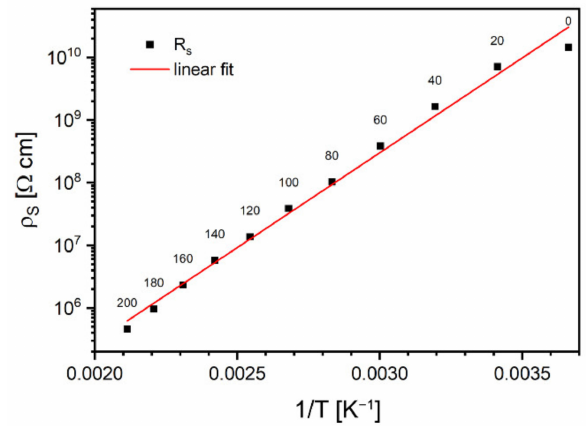
Figure 8. Arrhenius plot of static resistivity. Labels are temperatures in ◦